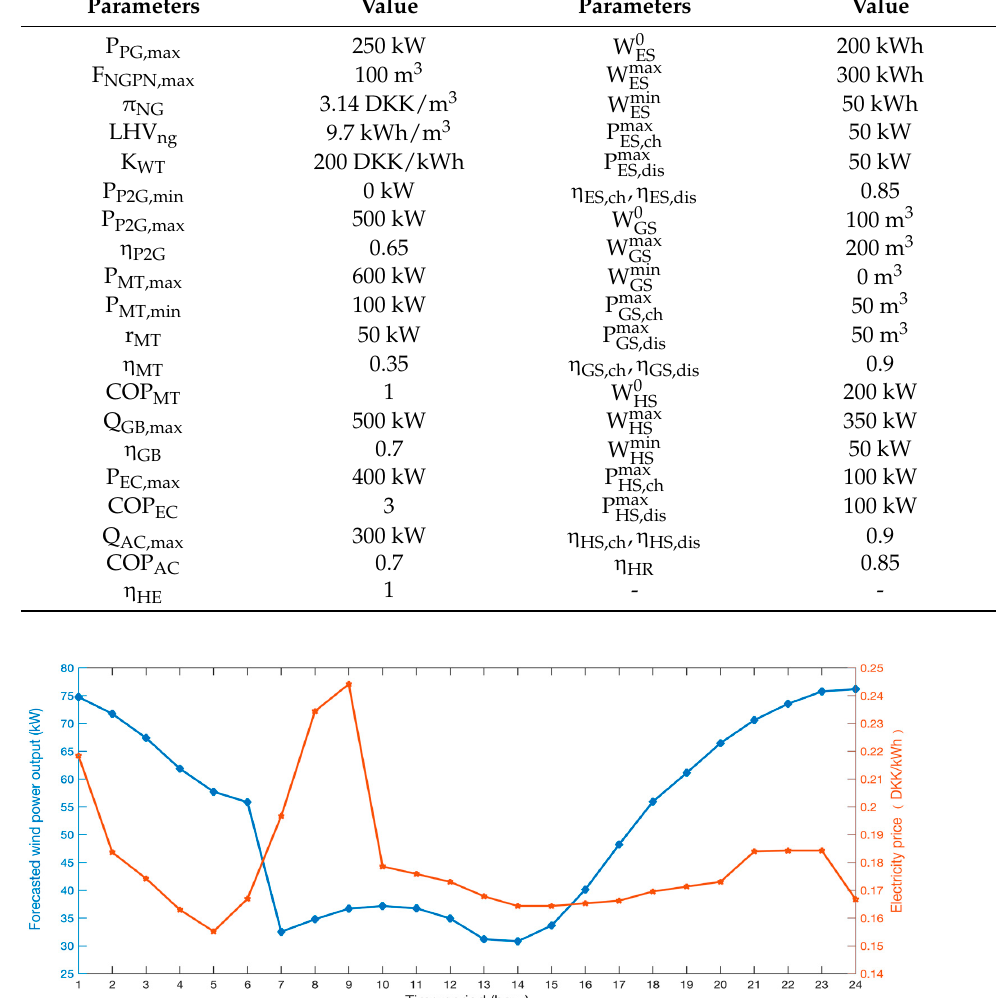
Figure 4. Hourly data of forecasted wind power output and electricity price.